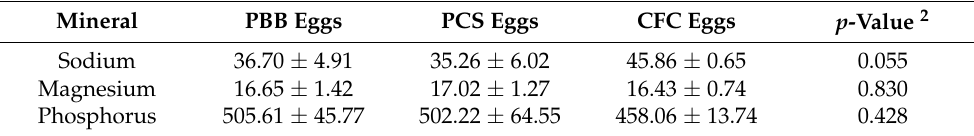
Table 8. Mineral profile of the egg yolks (mg/100 g fresh yolk) 1 .